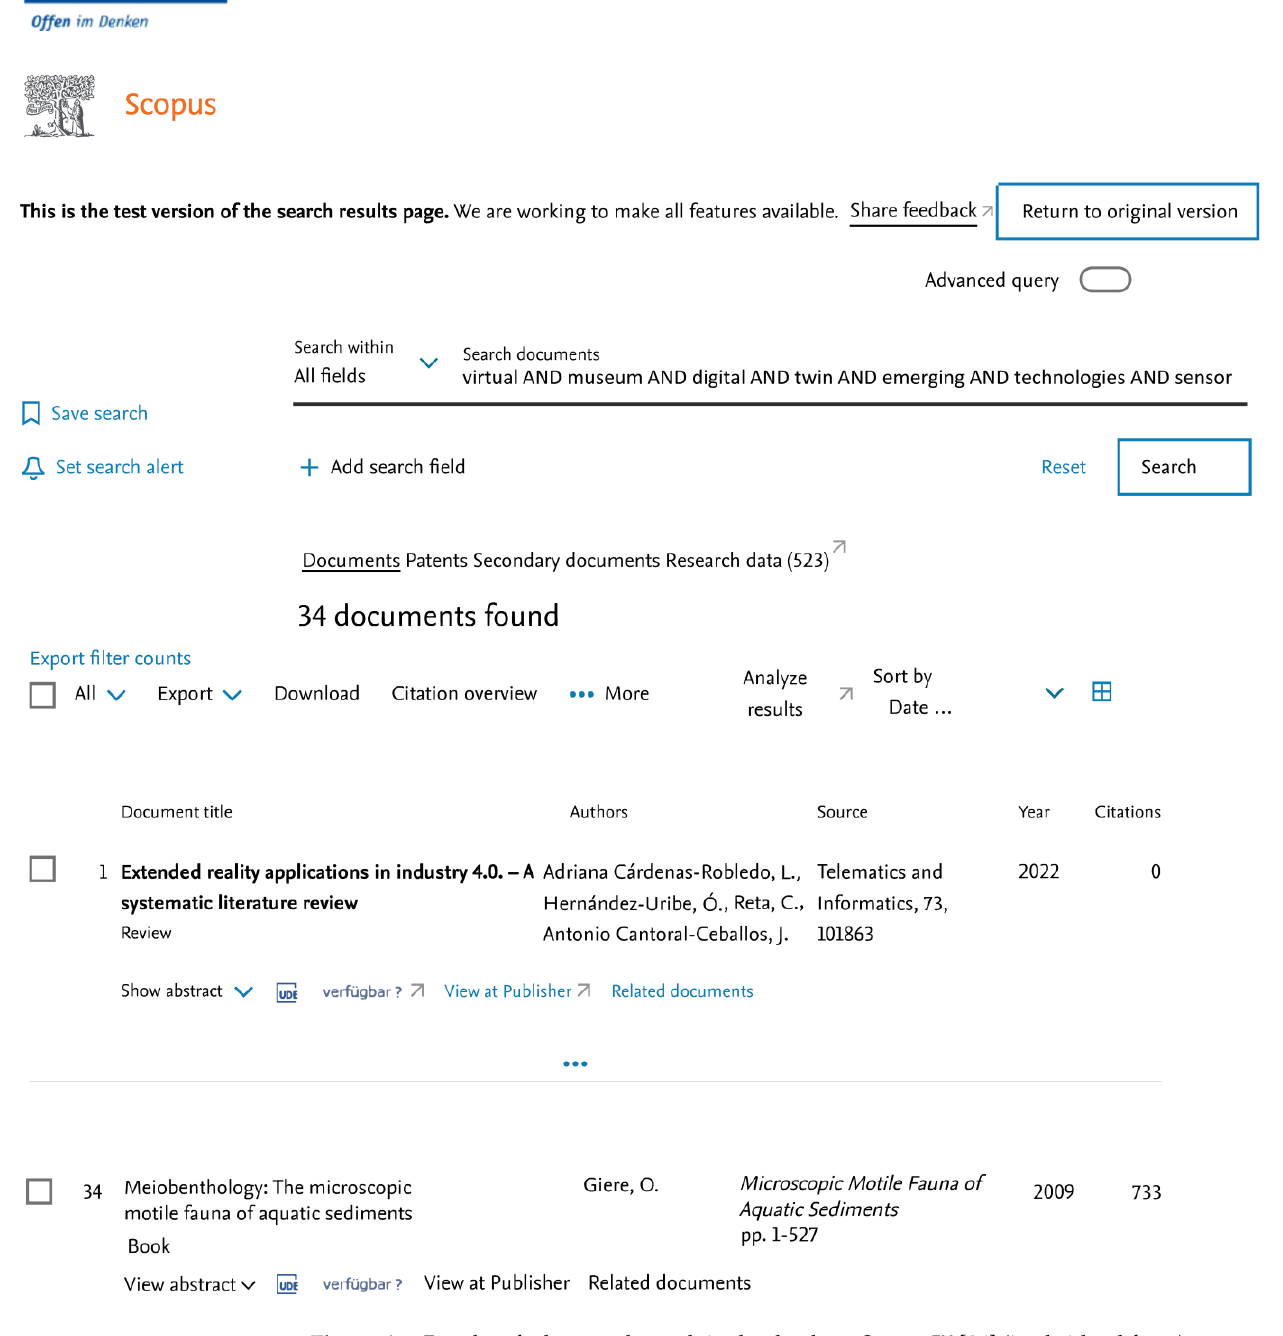
Figure A1. Results of a keyword search in the database Scopus™ [86] (in abridged form).